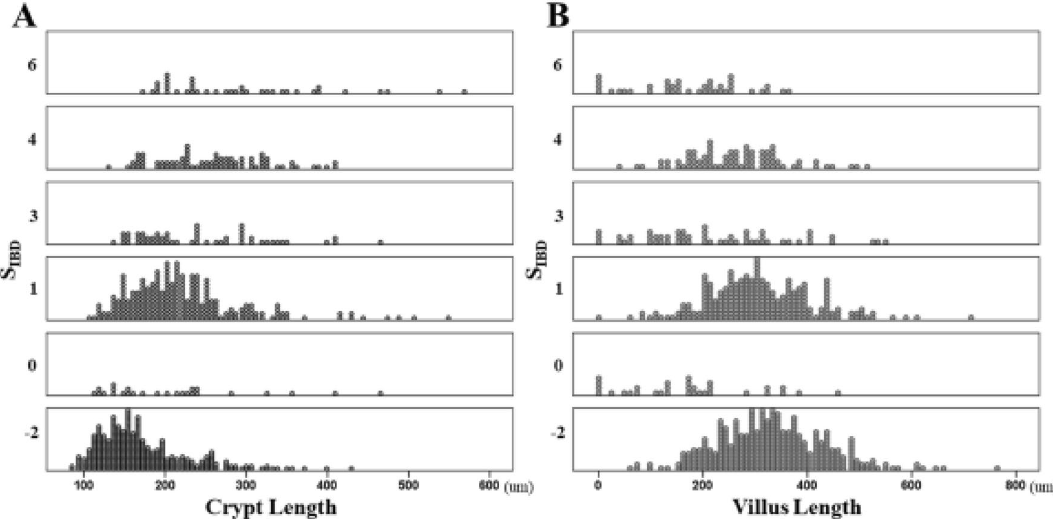
Figure 2. Correlation between CMS and S IBD . The crypt length correlated with the S IBD [A; r = 0.505; p < 0.001], the villus length did not correlate with the S IBD [B; r = −0.293; p < 0.001]. CMS-colonic metaplasia scores; SIBD-the IBD